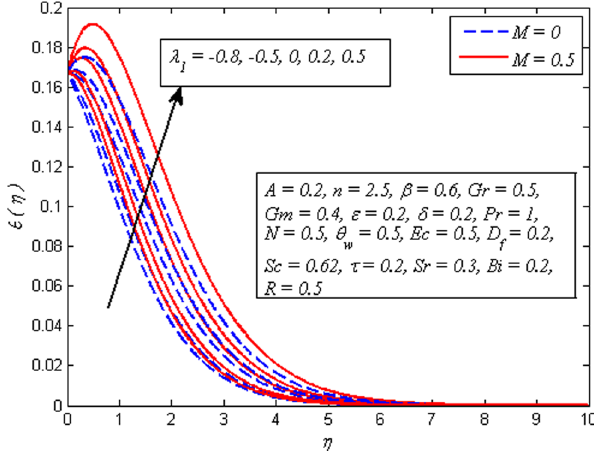
Figure 15. Effect of λ